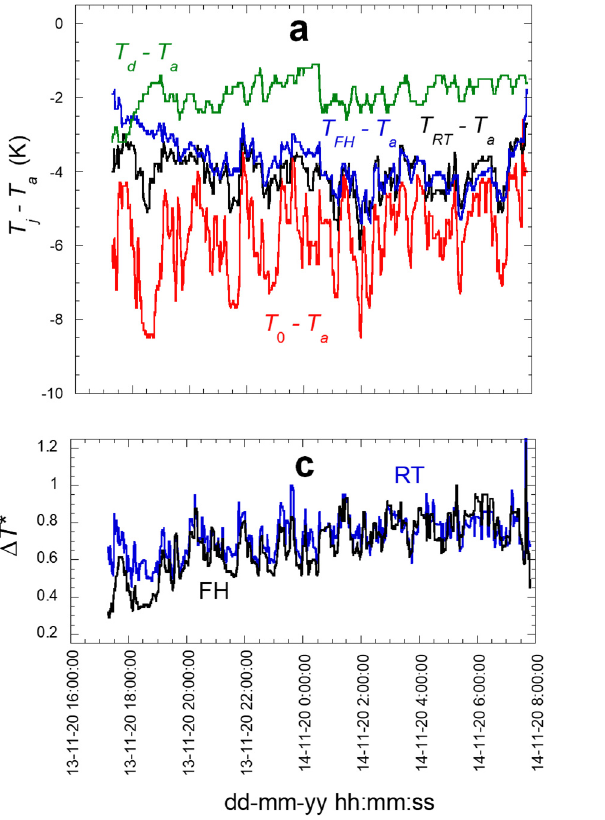
a of the temperatures of reference ( T 0 ), left ( T LW ), and right ( T RW ) windows. ( b ) Corresponding windspeed V and wind direction Dir V . ( c ) Cooling efficiency ratio ∆𝑇 (cid:3013)(cid:3024)∗ and ∆𝑇 (cid:3019)(cid:3024)∗ (left and right windows, respectively). ( d ): Left and right window cooling with respect to air temperature ( T LW,RW − T a ) as a function of windspeed V 10 extrapolated at 10 m from the ground. Curves are smoothing functions. During this night, dew yields were (REF) h REF = 0.265 mm.day − 1 , (LW) h LW = 0.039